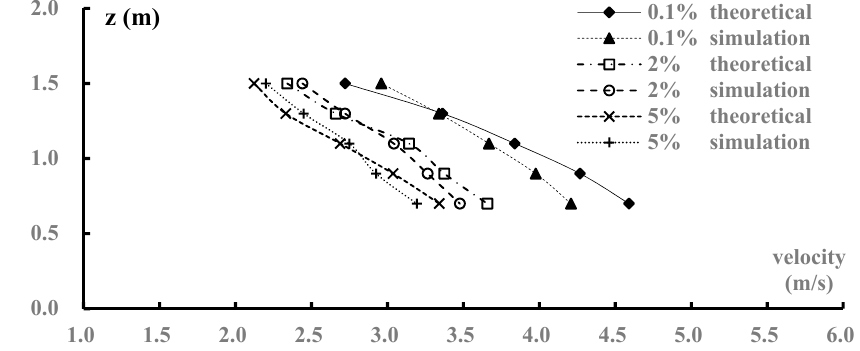
Figure 11. Comparison of the simulated and theoretical average velocity in the shaft section.